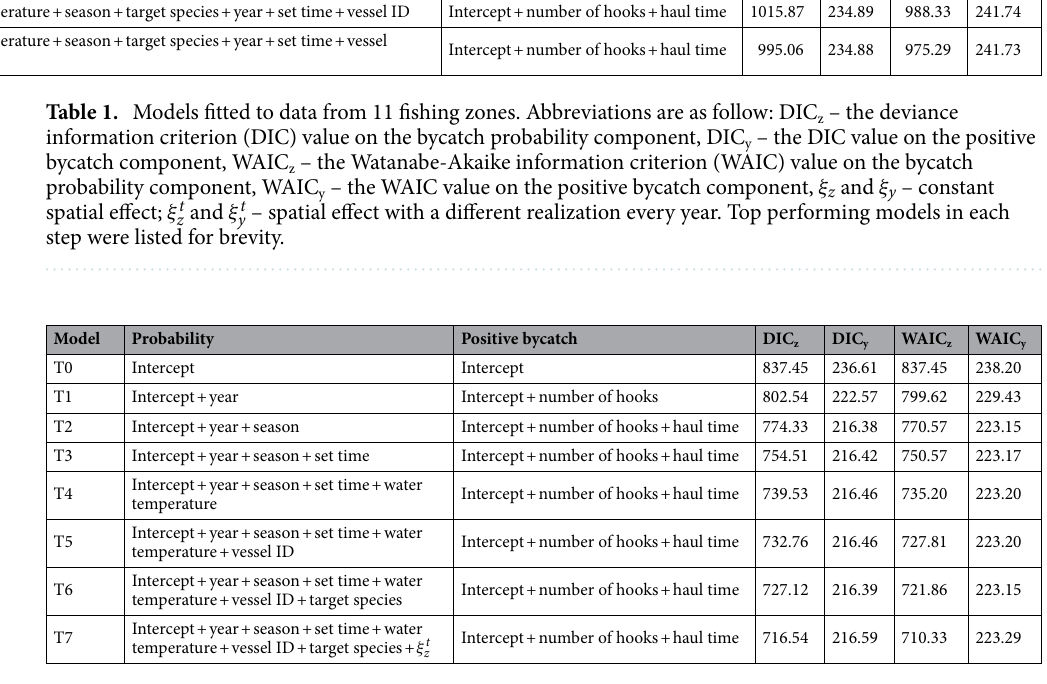
Table 2. Models fitted to data from the three high-bycatch zones. Abbreviations are as follow: DIC z – the deviance information criterion (DIC) value on the bycatch probability component, DIC y – the DIC value on the positive bycatch component, WAIC z – the Watanabe-Akaike information criterion (WAIC) value on the bycatch probability component, WAIC y – the WAIC value on the positive bycatch component, ξ z and ξ y – constant spatial effect; ξ t z and ξ t y – spatial effect with a different realization every year. Top performing models in each step were listed for